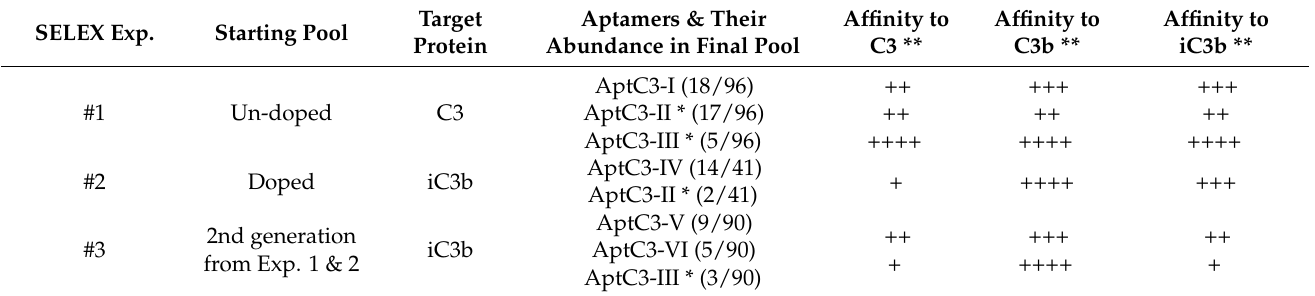
Table A1. Selection and characterization of aptamers for C3 and its